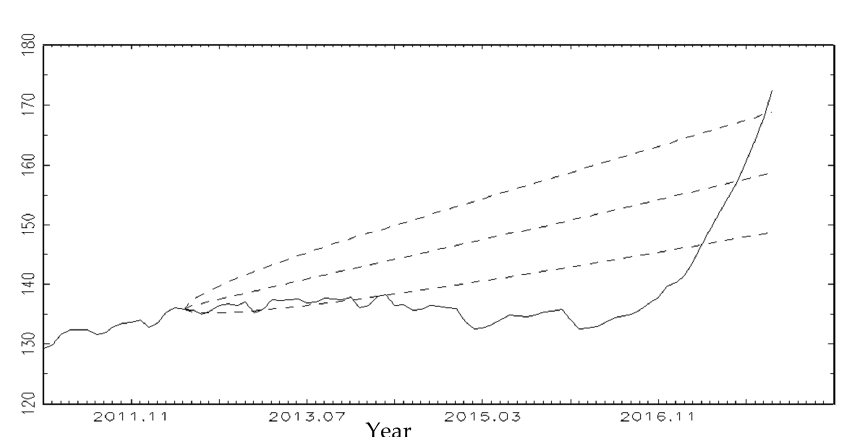
Figure A3. Time series forecasting for CPIEA, the in-sample January 2000–May 2012, and the out-